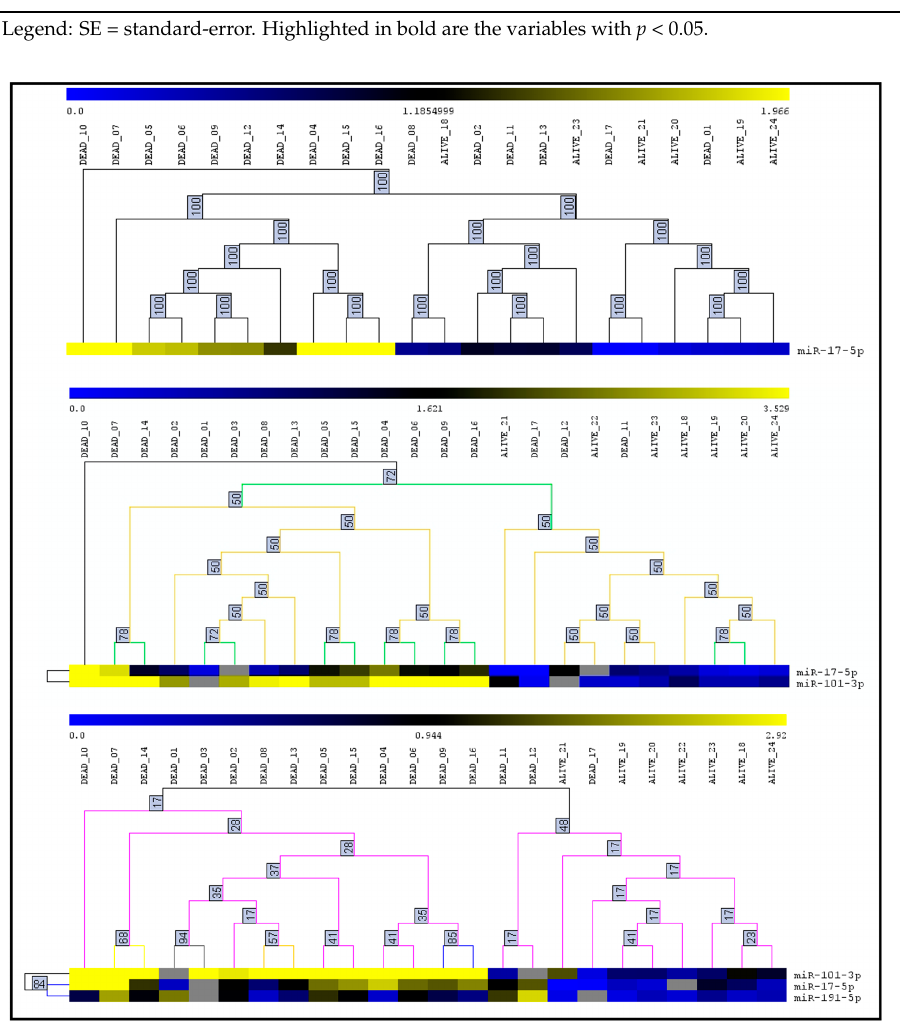
Figure 1. Heatmaps demonstrating the differently expressed microRNAs and hierarchical cluster analyses of all samples at the differentiation between dead patients due to papillary thyroid carcinoma progression from those alive with stable metastatic disease (without tumor progression at long follow-up), considering only the microRNAs differently expressed at the multivariate analysis (overexpression of miR-17-5p, miR-101-3p, and miR-191-5p). Yellow spots represent samples with high expression and those in blue low represent microRNAs expression. Values greater than 0.861, 2.155, and 0.455 were established as the ROC curve cutoff values of miR-101-3p, miR-17-5p, and miR-191-5p, respectively, for the evaluation of death of patients with metastatic PTC. The three models showed high accuracy in predict- ing the mortality of patients with metastatic PTC, as shown in Table 4. None of the patients with these microRNAs expression bellow the cutoff value died; therefore, the specificity is 100%. However, the low number of patients in both groups did not allow the analysis of the risk of death by logistic regression of the cutoff values of the three miRNAs.